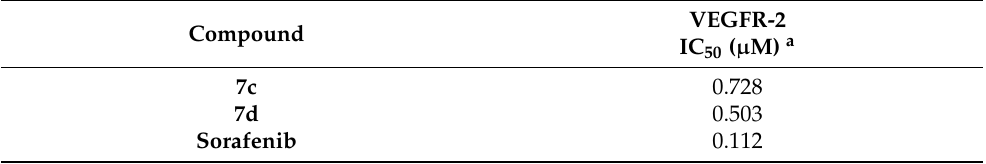
VEGFR-2 IC 50 ( µ M) a